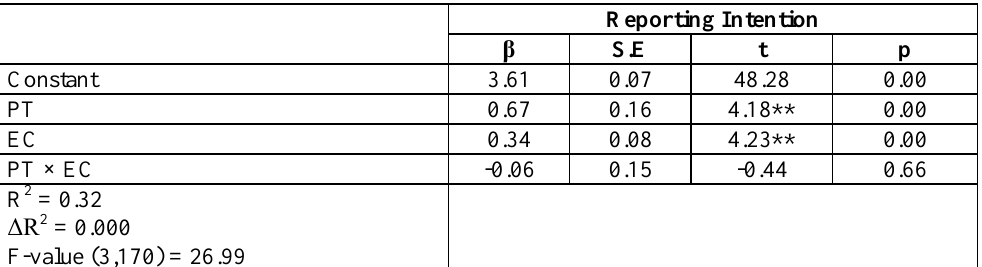
Table 1. Results of Moderating Effects of Ethical Culture on Relationship between Personality